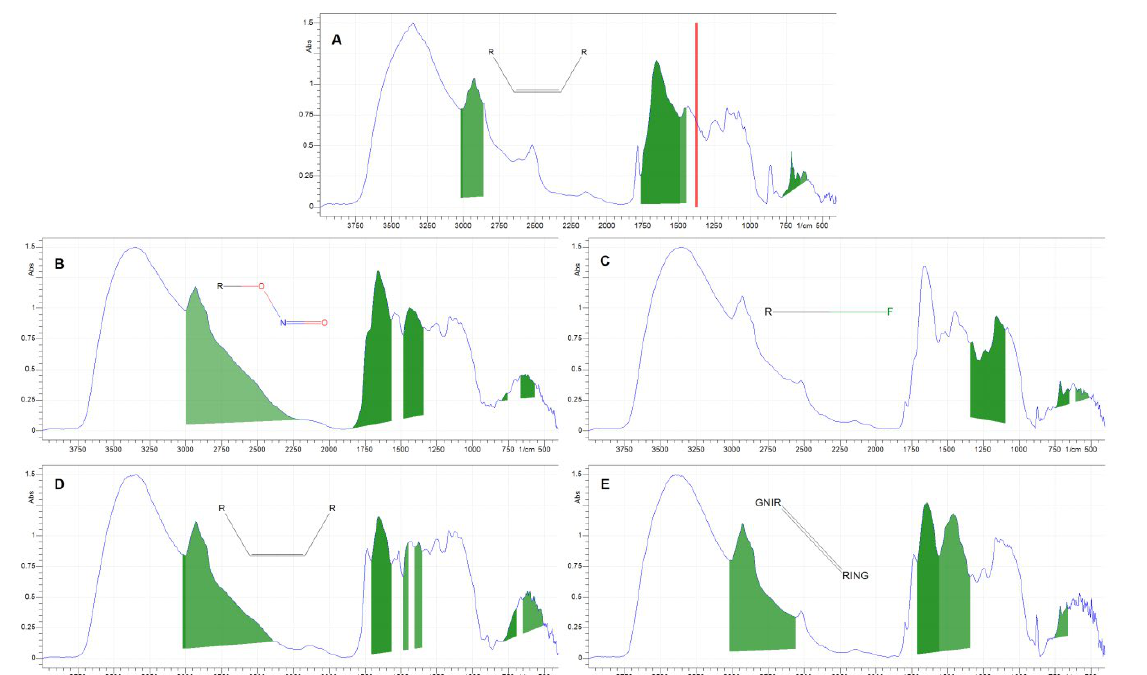
Chara vulgaris (A) Salvinia natans (B), Ceratophyllum Figure 3. (C) Schoenoplectus litoralis (D) Typha australis (E) FTIR spectrum analysis of air-dried , spp. , Chara vulgaris Salvinia natans Ceratophyllum , and samples collected from Al-Chibayish marsh Schoenoplectus litoralis Typha FTIR spectroscopic analysis for some of Al-Chibayish marshes plants ( , , , , and